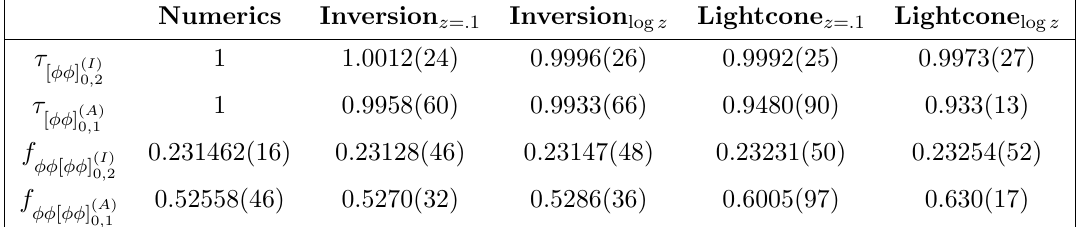
in the 0 ,(cid:30)